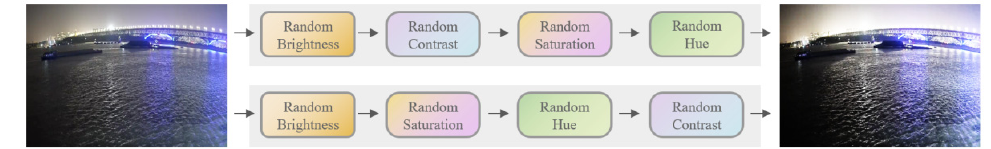
Figure 8. Image multi-random augmentation architecture.